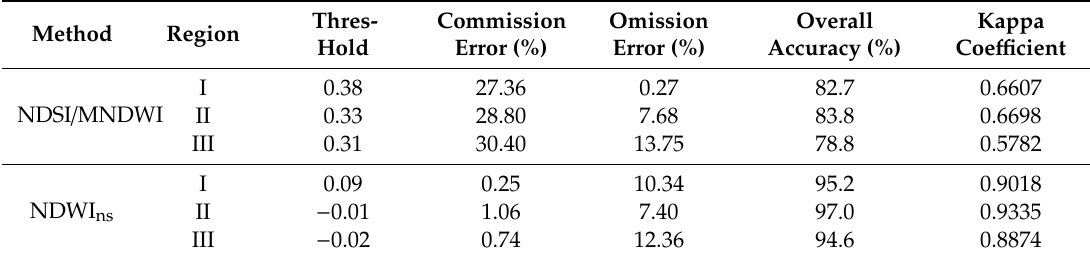
Table 5. The extraction accuracy of lake water from